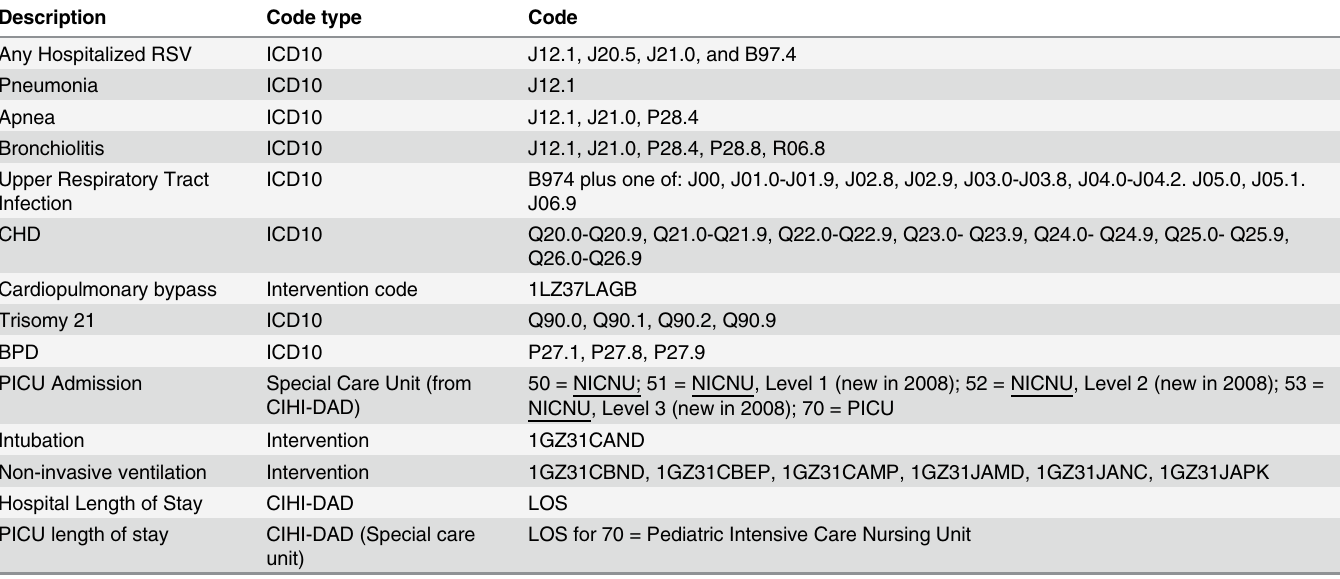
Table 1. International Classification of Disease 10 codes for patient diagnoses and